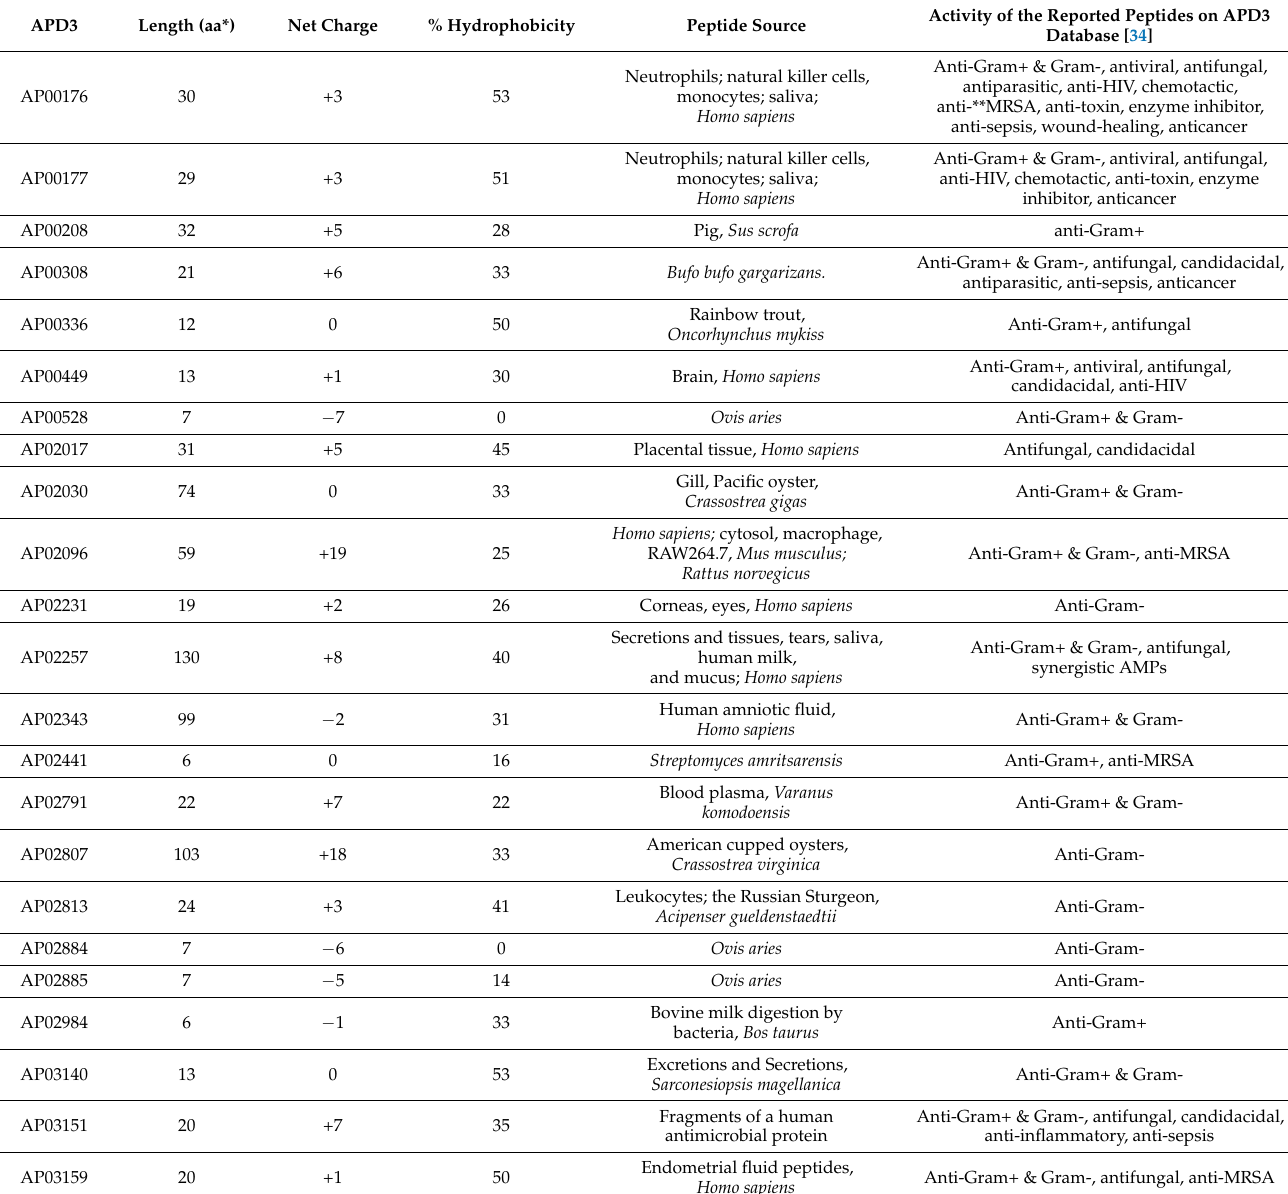
Table 1. Peptides reported in APD3 that appeared to be 100% identical to some hypothetical proteins of B. ramosi